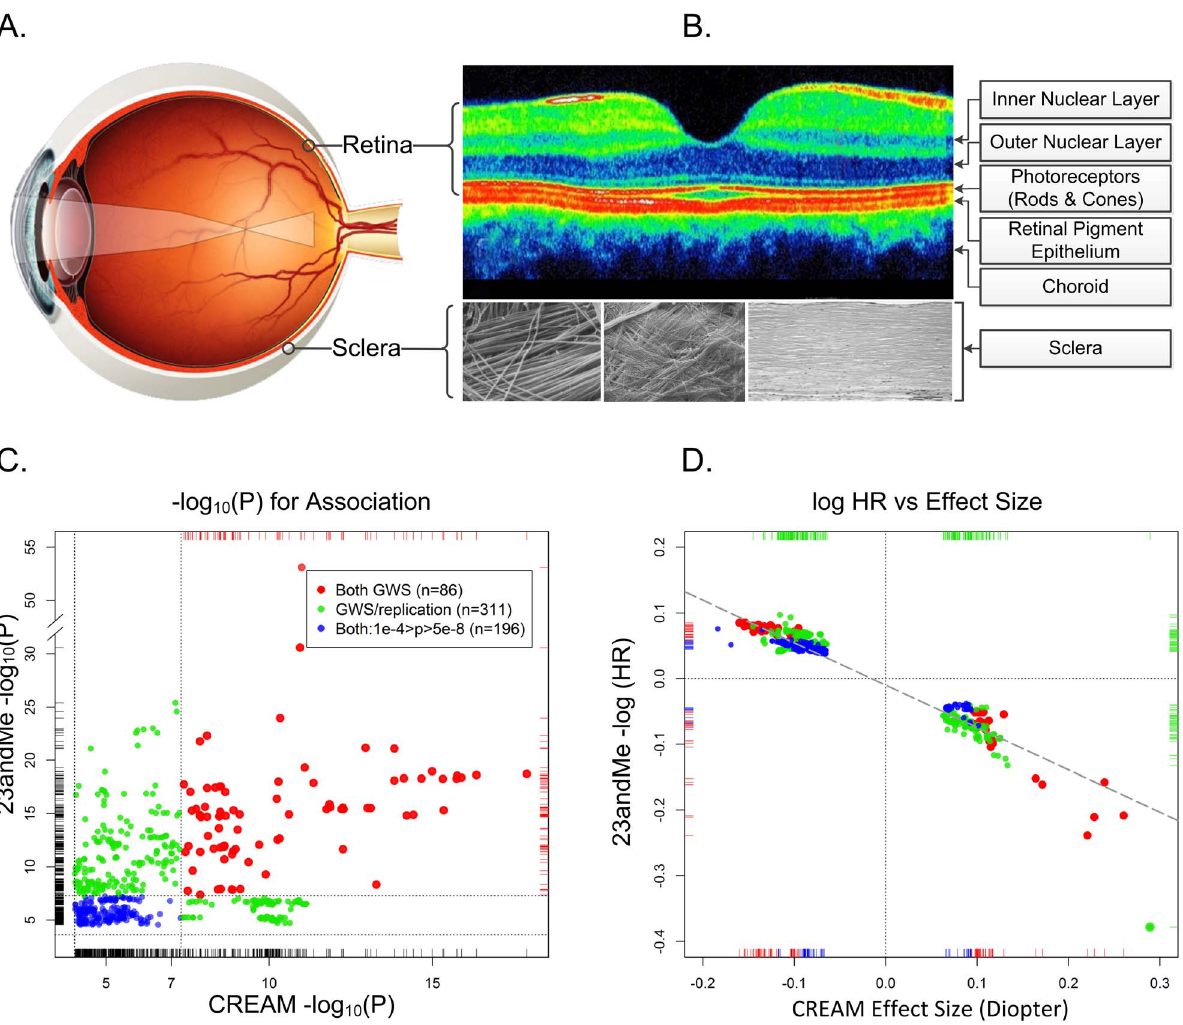
Figure 1. The physical, biological, and genetic basis of myopia. Panel A. The optical basis of myopia. Parallel lights from distantly viewed object focus anterior to the retinal plane, causing blurred distance vision. Although myopia can result from alterations in the optical system (the cornea and lens), myopia is almost always the result of excessive growth of the posterior segment of the eye. This growth occurs through active remodeling of the fibrous sclera. Panel B. Optical coherence tomography cross section of a normal posterior pole. The depression in the middle is the fovea, where the concentration of photoreceptors (and by extension the visual acuity) is greatest. Only four of the ten layers of the neural retina are pointed out. In refractive regulation, visually induced signals are generated by the photoreceptors and processed by other retinal cells (notably, by the amacrine cells, which release neuromodulators and neurotransmitters (including dopamine)). These retinal signals must traverse the retinal pigment epithelium and the highly vascularized choroid in order to regulate eye growth through active remodeling of scleral ECM. The sclera is composed mainly of collagens, but also contains active fibroblasts and normal constituents of ECM (proteoglycans, MMP s, TIMP s, etc.). The composition of the sclera with its organized structure of collagen fibrils are shown under three different magnifications. Panel C. Statistical significance and effect sizes for 23andMe and CREAM studies. Statistical significance of overlapping SNPs with association p-values , 1e-04 in both datasets are plotted. Red dots show SNPs that were genomewide significant (GWS; p , 5e-08, 2 log 10 (p) . 7.3) in both studies. Green dots represent SNPs that were genomewide significant in one study and fulfilled our statistical criterion for replication in the other study. Blue dots show SNPs whose p-values for association were between p=10e-4 and 5e-8 in both datasets. The replication thresholds were the Bonferroni-corrected p-values for a family-wise error rate of 0.05: since the CREAM dataset contained 544 (nonindependent) SNPs that were genomewide significant in 23andMe, the Bonferroni-adjusted p-value threshold for replication was 0.05/544=9.2e-05 (or 2 log 10 (p)=4.037). Similarly, there were 308 genomewide significant SNPs in CREAM that were also in the 23andMe dataset presented in Table S2 of Kiefer et al. The replication threshold was therefore 0.05/ 308=2.4e-04 ( 2 log 10 (p)=3.615). Dotted horizontal and vertical lines show the thresholds for genomewide significance and replication. Panel D. Natural logarithm of hazard ratios for myopia in 23andMe vs. effect size (beta coefficient) in CREAM. Both analyses assumed an additive effect of the representative allele on the scale used in the analyses. Color coding is identical to the left panel. The dashed diagonal line shows the linear regression of the 23andMe log hazard ratios on CREAM effect sizes. All SNPs are concordant as to the expected direction of their effects (i.e., positive HRs for myopia would be expected to increase the severity of myopia and negative HRs would be expected to decrease the degree of myopia). Dotted lines show the origins where the effects are null.